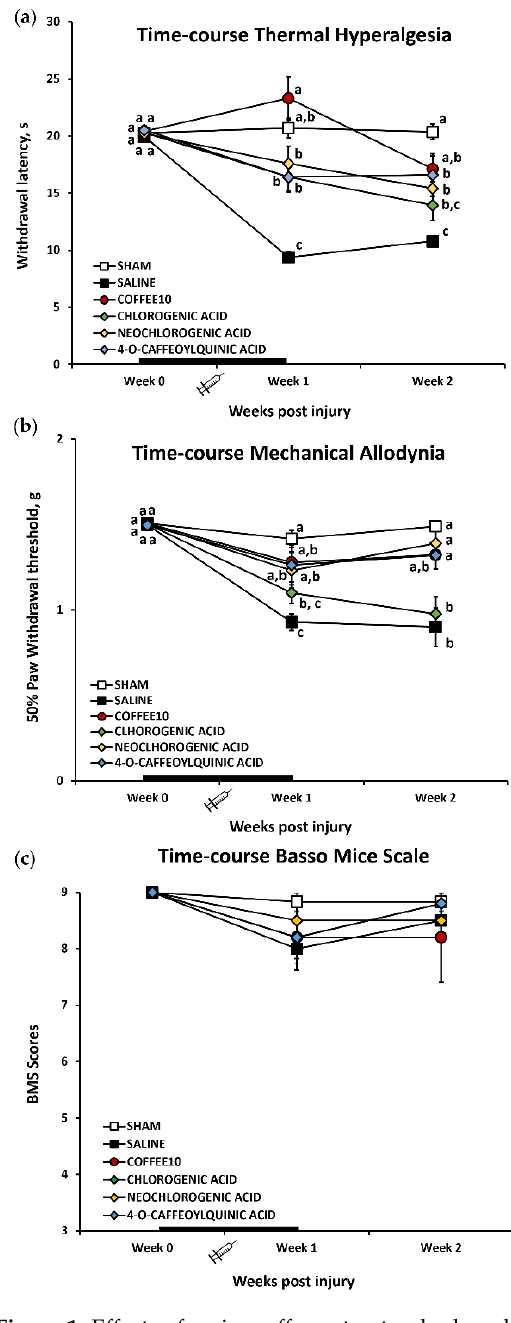
Figure 1. Effects of major coffee extract polyphenolic compounds on reflexive pain responses and locomotor activity: ( a ) thermal hyperalgesia; ( b ) mechanical allodynia; ( c ) BMS scores. Data are illustrated as mean ± SEM. a–c: not sharing a letter means significant differences, p < 0.05. Administration week (W0 to W1) is indicated with a thicker line.